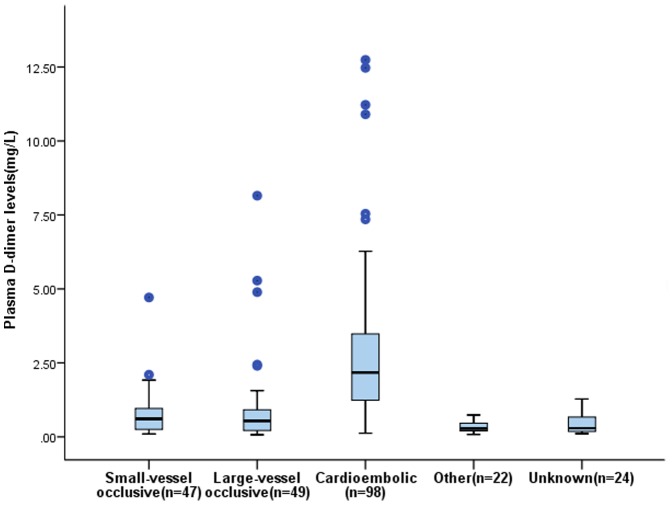
Plasma D-dimer levels in different etiology of acute ischemic stroke patients.Significant differences in plasma D-dimer levels were observed (analysis of variance [ANOVA]: p = 0.000).